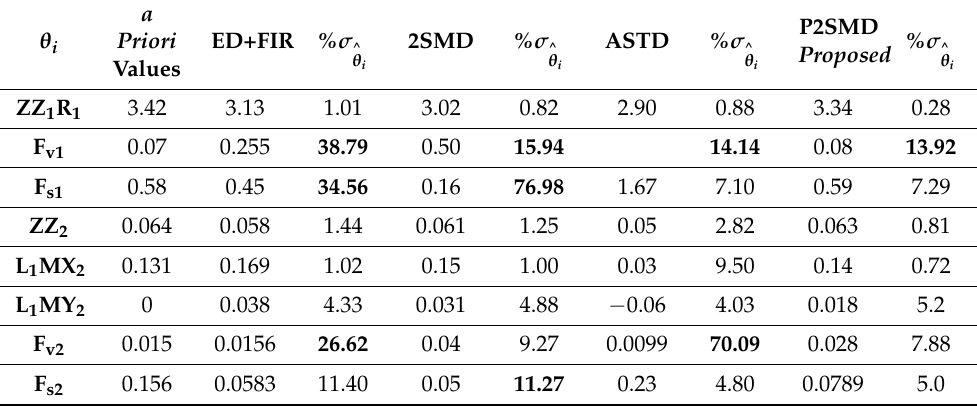
Table 2. Estimated parameters and the relative standard deviation values. High values are noted in bold.